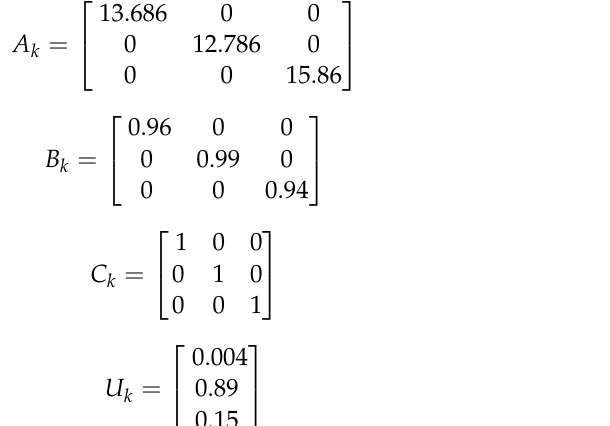
Figure 11. Temporary behavior of the covariance of the identification error P T x - and y